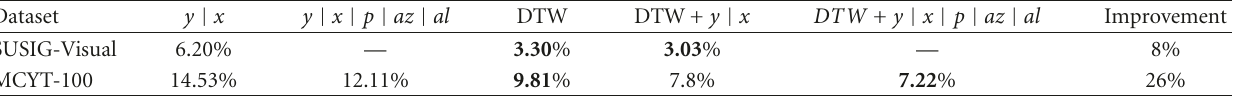
Table 5: Results of the fusion of the FFT system with our Dynamic Time Warping system.